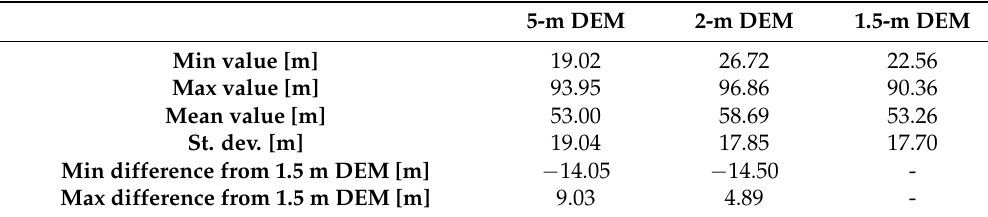
Figure 11. ( a ) Part of the Geoeye-1 sample used in the study and ( b ) visual comparison of produced 1.5-m Digital Elevation Models (DEM) with ( d ) reference 2-m DEM produced from the Geoeye-1 using ERDAS ® and ( f ) 5-m commercial DEM from aerial photo stereo pair, and difference between the produced 1.5-m DEM and the reference 2-m DEM ( c ), as well as the 5-m commercial DEM ( e ). Red arrows denote areas of interest for comparison. Table 1. Statistics and goodness of fit metrics of the two reference DEMs (5-m and 2-m resolution) and the newly produced DEM (1.5-m resolution).